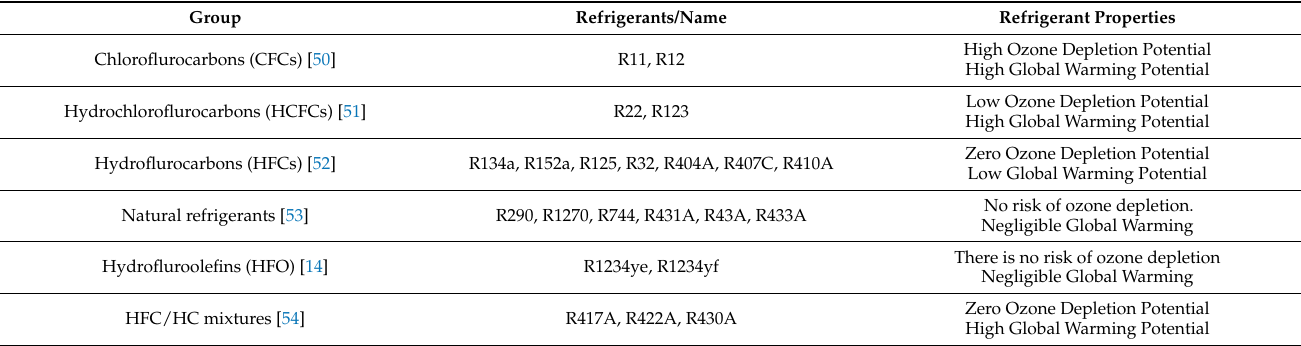
Table 2. Refrigerants that can be used in SAHP